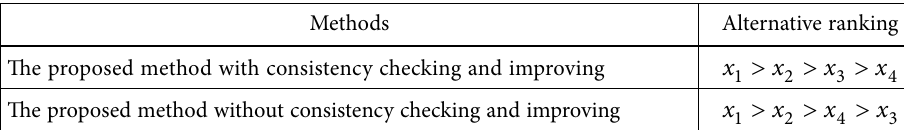
Table 4. Rankings based on two methods (source: our research) Methods Alternative